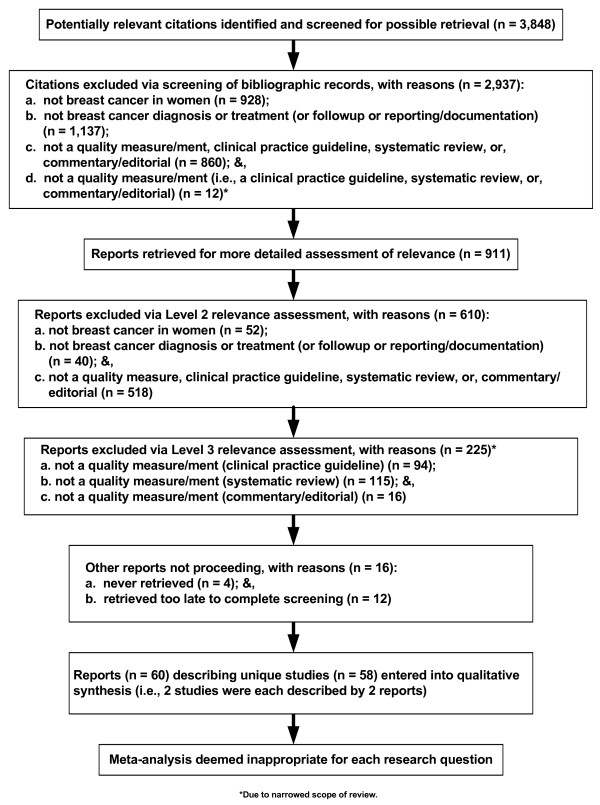
Modified QUOROM Flow Chart.